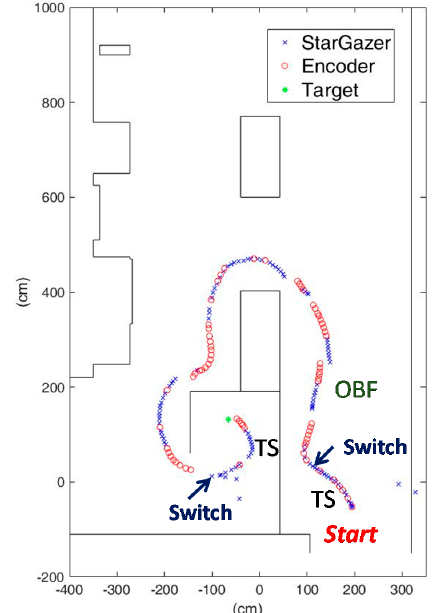
Figure 11. The navigation trajectory of the robot in a real unknown environment, where “×” represents the localized position from the Stargazer localizer and “o” represents the localized position using the rotary encoders. Inventions 2018 , 3 , 3